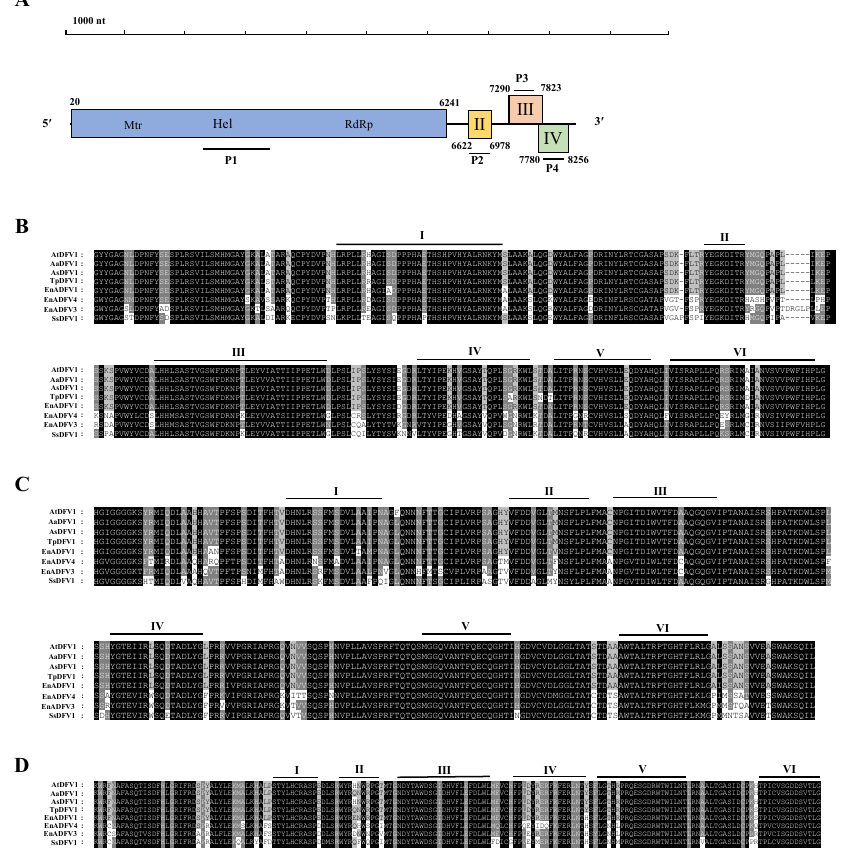
Figure 3. AtDFV1 genomic organization. ( A ) Organization and genome size with two conserved domains in the RdRp protein. Boxes indicate the position and size of each ORF and are labeled with Roman numerals, except for ORF I which encodes RdRp protein. ( B – D ) Amino acid sequences of the viral methyltransferase, viral RNA helicase, and RNA-dependent RNA polymerase, respectively, of AtDFV1 with members of the family of Deltaflexivirus . Black indicates the conserved sequences, shading indicates the conserved sequence level, and the darkest color indicates the most conserved sequence. For abbreviations of virus names and viral protein accession numbers used in alignment analysis, see Supplementary Table